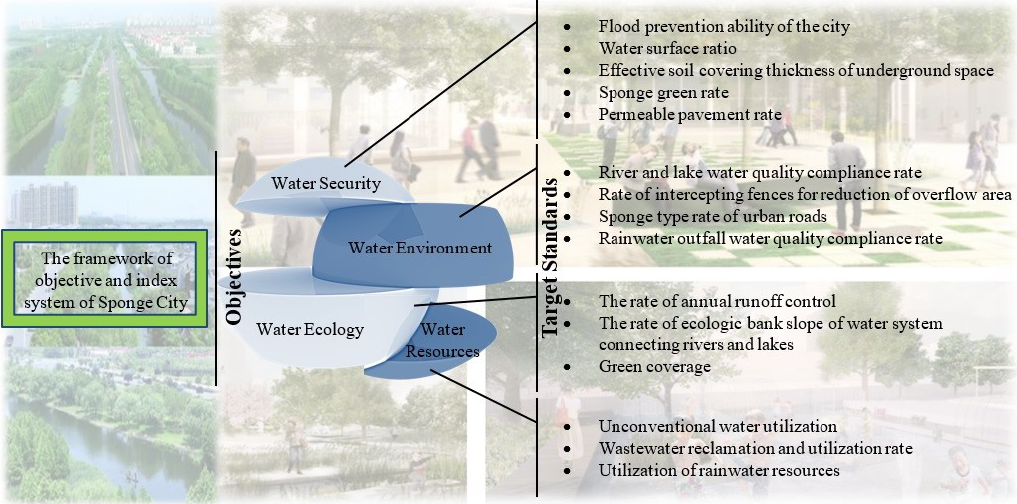
Figure 4. The framework of objectives and index systems for sponge